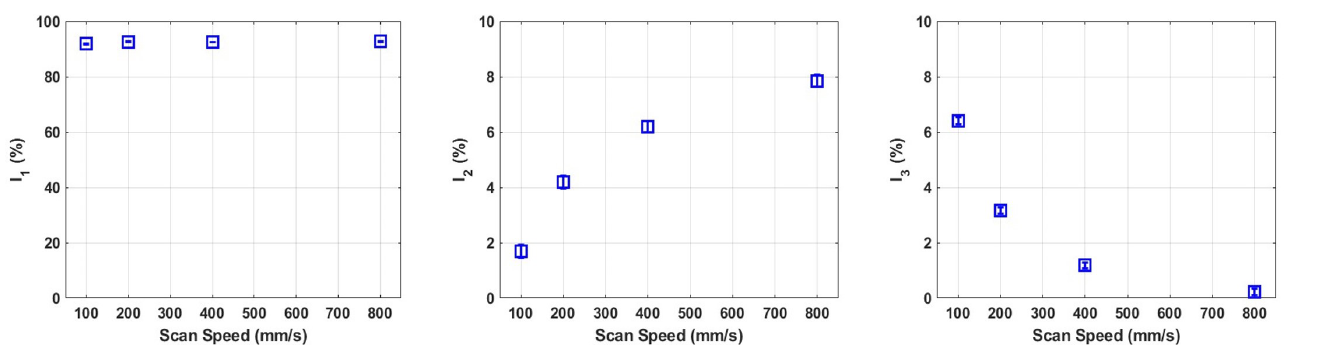
Figure 9. Constrained fitting for LPBF Mo-0.1SiC. The intensities correspond to the three fixed lifetime components: 135, 261, and 430